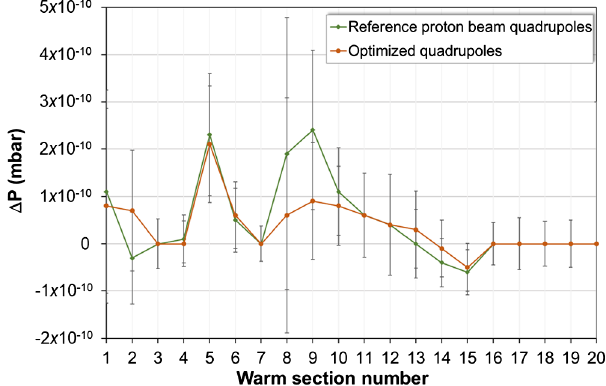
FIG. 6. Ellipticity for the 16 kW beam power (blue) and for the reference proton beam (red).